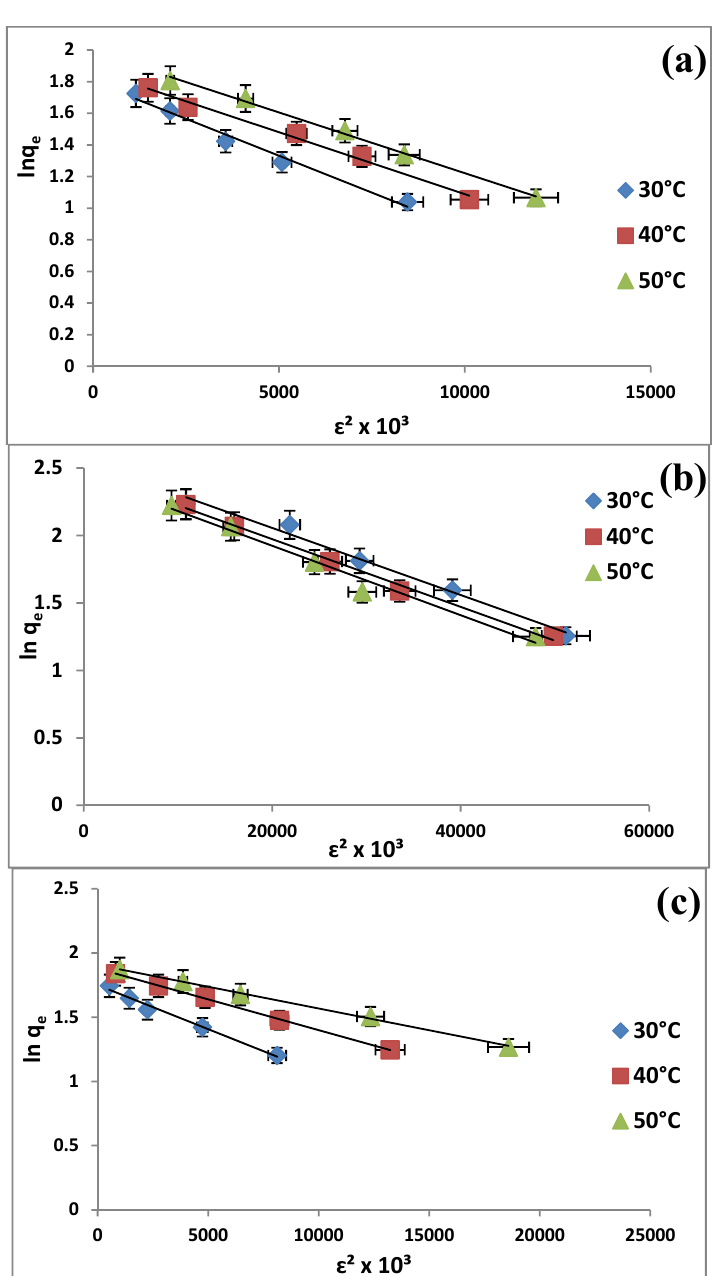
Figure 9. Dubinin-Radushkevitch isotherm of TBT adsorbed onto MCM-TDI-C4 ( a ),